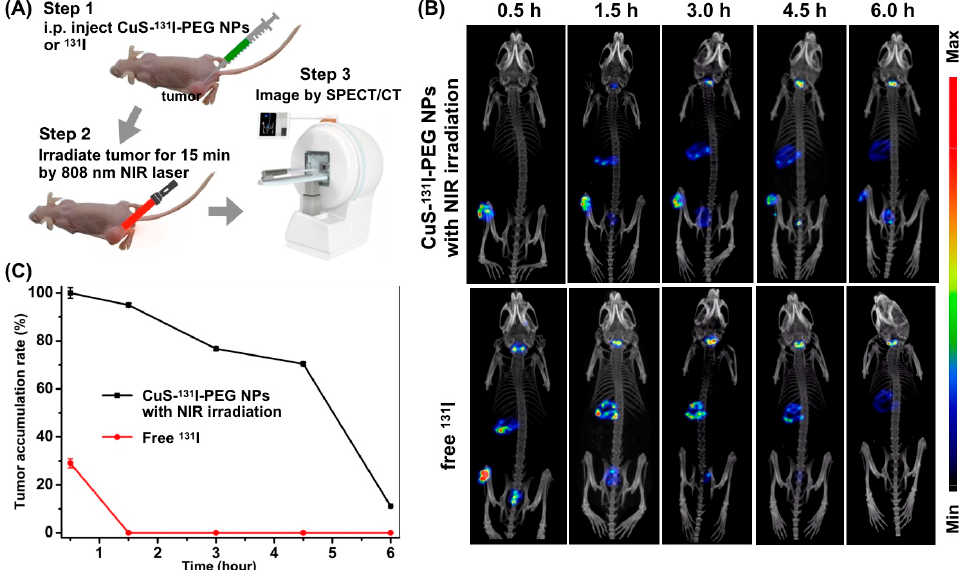
Figure 5. SPECT images for intratumoral accumulation and metabolic process of 131I after intratumoral injection of CuS-131I-PEG nanotheranostics and 131I, respectively. ( A ) Schematic illustration of process in tumor accumulation study. ( B ) SPECT images of 131I after intratumoral injection of CuS-131I-PEG nanotheranostics and 131 I for 6.0 h, respectively. ( C ) Quantification of tumor accumulation rate of 131 I.